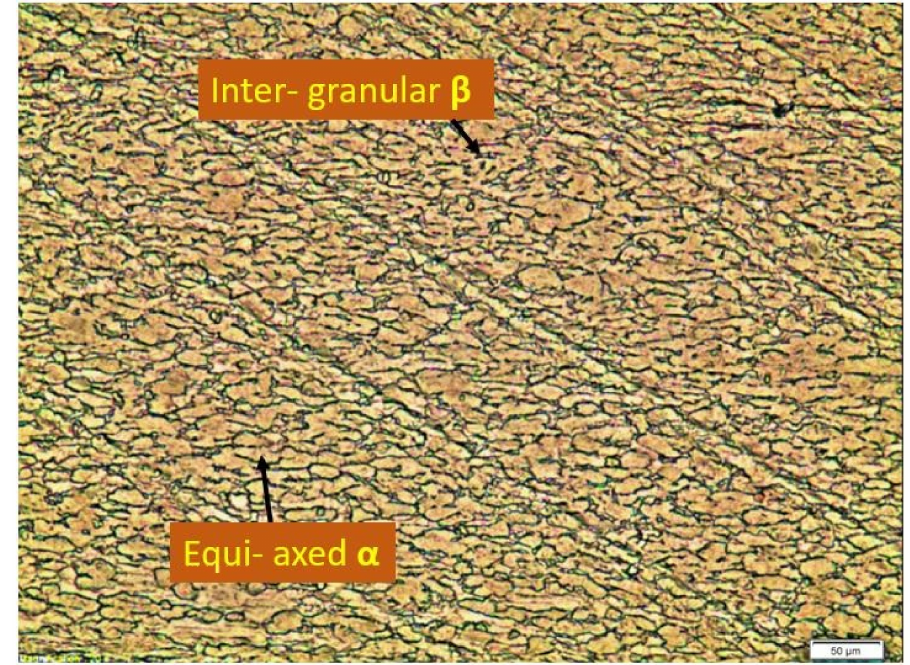
Figure 6. The microstructure of BM (Ti6Al4V titanium